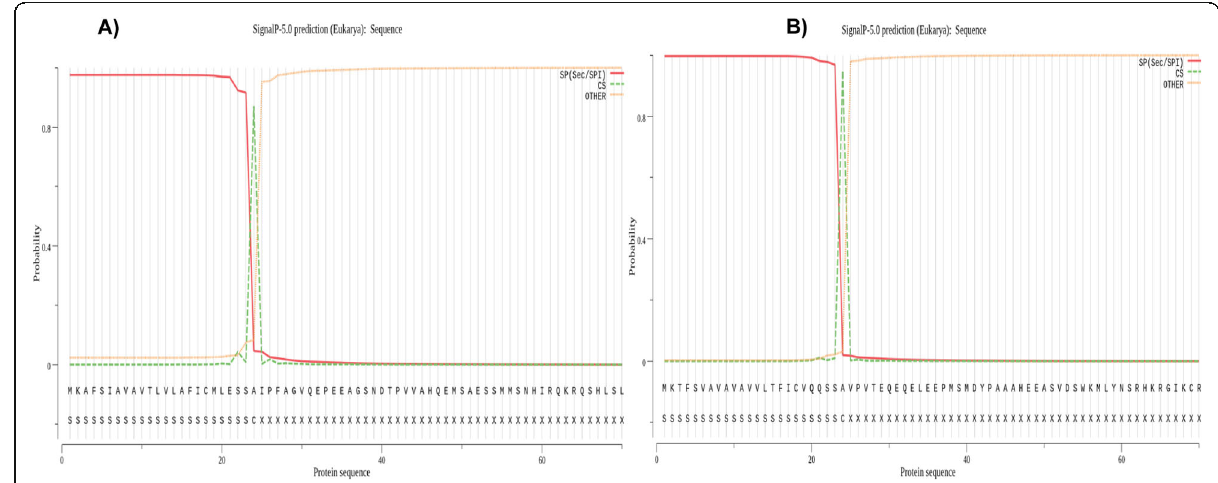
Fig. 11 a , b Signal peptide analysis of O. niloticus , T. zillii , and S. galilaeus species hepcidin 1 ( b ) and hepcidin 2 ( a ) gene indicated to the cleavage site is predicted between amino acids 24 and 25 with probability (0.9753 and 0.9968,